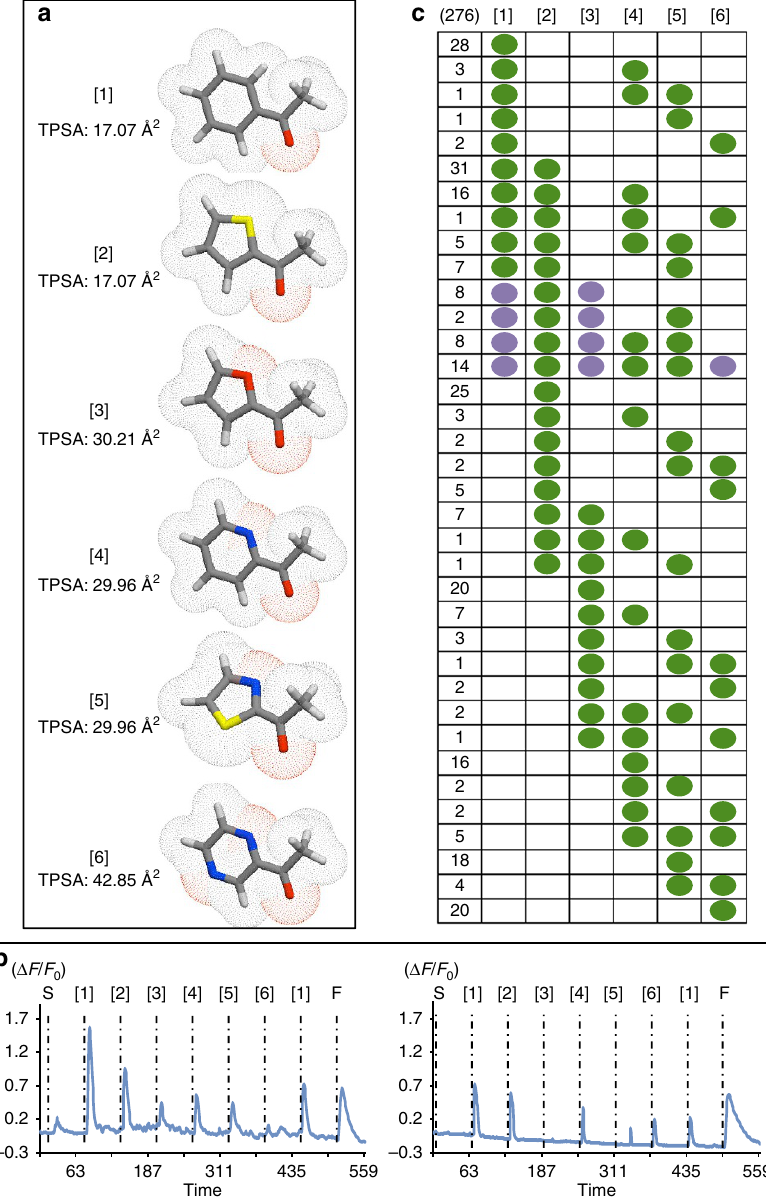
Figure 1 | Reponses of dissociated OSNs to Panel 1 odorants in calcium imaging. ( a ) Three-dimensional (3D) representations of Panel 1 odorants. The vertices of the tubes symbolize atoms—grey, carbon; blue, nitrogen; yellow, sulfur; red, oxygen. The dotted red surface around the atoms represents polar regions of the surface area. 3D-representations of these and all odorants used in the study were made using Galaxy 3D Structure Generator free software (www.molinspiration.com.) and TPSA were calculated according to ref. 36. ( b ) Calcium imaging traces of two different OSNs responding to Panel 1 odorants. ( c ) A total of 276 OSNs out of 2,750 viable OSNs responded to at least one Panel 1 odorant, leading to 36 distinct binary response patterns. The numbers indicate how often a particular response pattern was observed. Green dot: activation of the OSN by the corresponding odorant. The OSNs that respond to [1] and [3] always respond to [2] (Purple dot). OSN that respond to [1], [3] and [6] always respond to all the odorants of the panel (Purple dot). S, dimethyl sulfoxide; F,